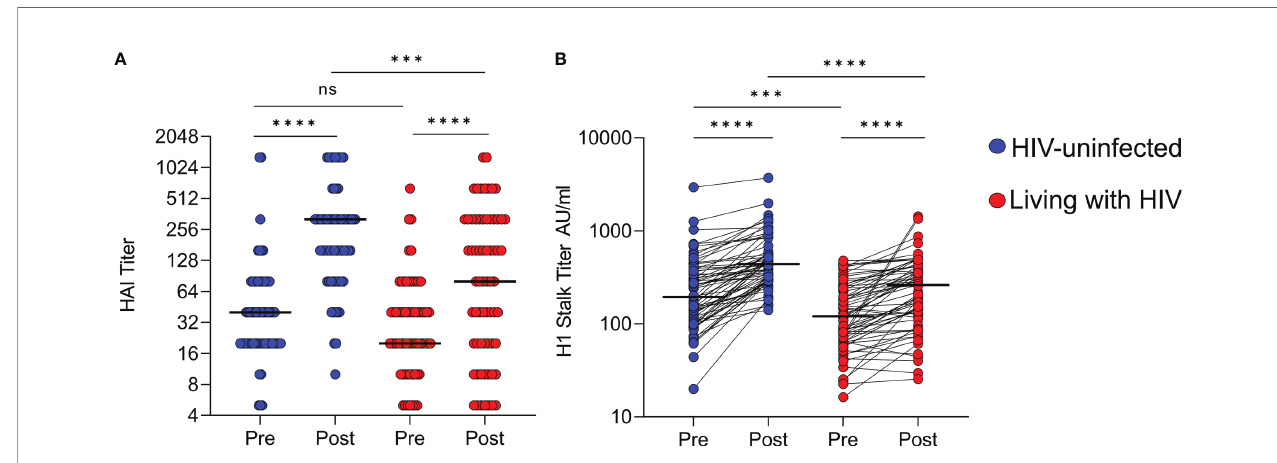
FIGURE 1 | A/H1N1 HAI and H1 stalk antibody responses amongst vaccinated women. (A) Pre-vaccination and 1-month post-vaccination hemagglutination inhibition (HAI) titers against A/H1N1 and (B) H1 stalk titers by ELISA, with HIV-uninfected participants (n=67), shown in blue and participants living with HIV (n=66), shown in red. The lines represent the median. Wilcoxon matched-pairs signed rank test used to compare pre- and post-vaccination titers. Mann Whitney U test used to compare responses between vaccine groups. Signi fi cant associations shown as ****p < 0.0001; ***p < 0.001; ns,not signi fi